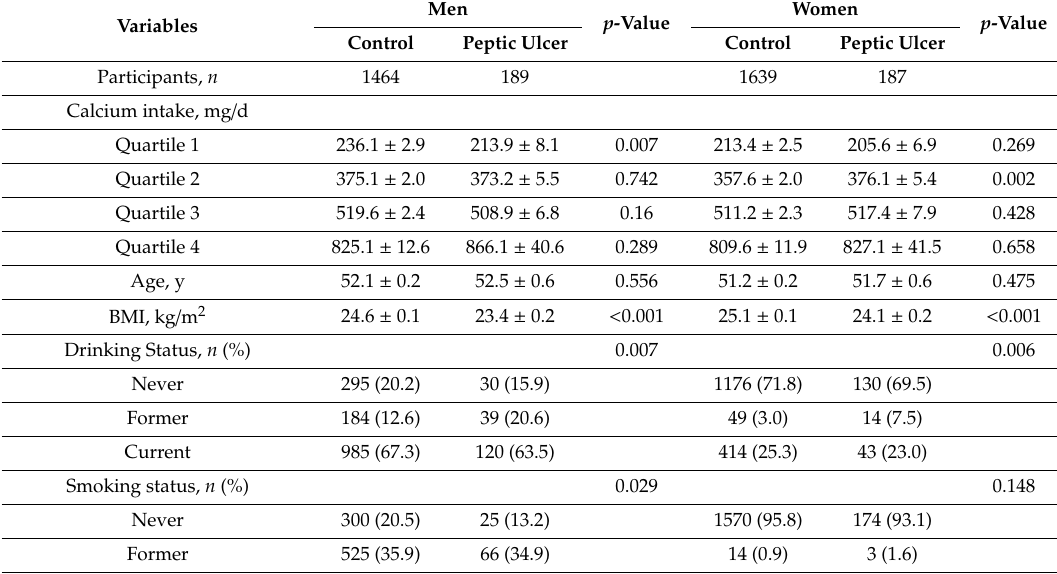
Table 1. Baseline characteristics in men and women with or without peptic ulcer